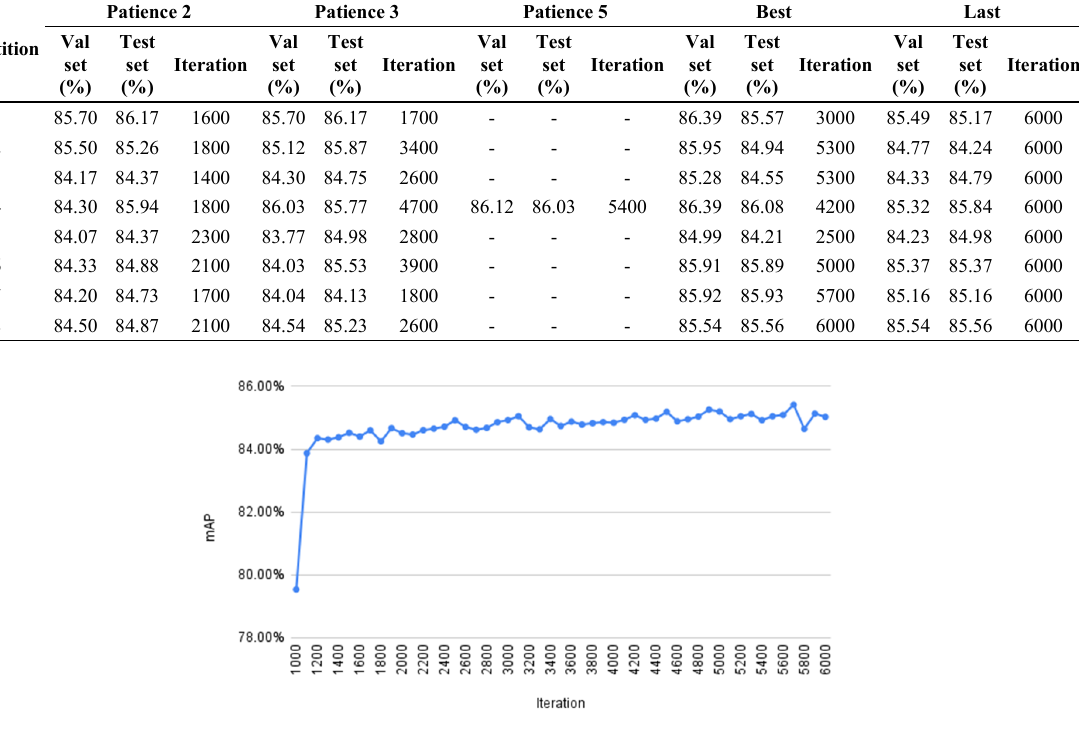
Fig. 4 Average mAP of all mask dataset experimental